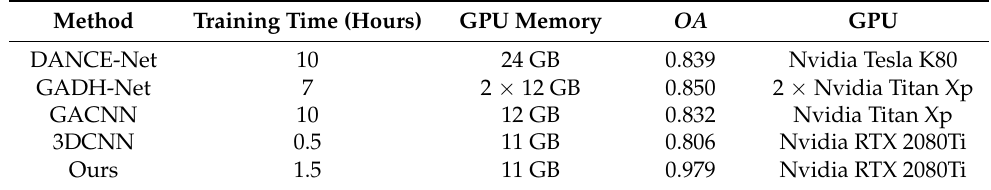
Table 8. The computation time, GPU memory, OA, and GPU of different